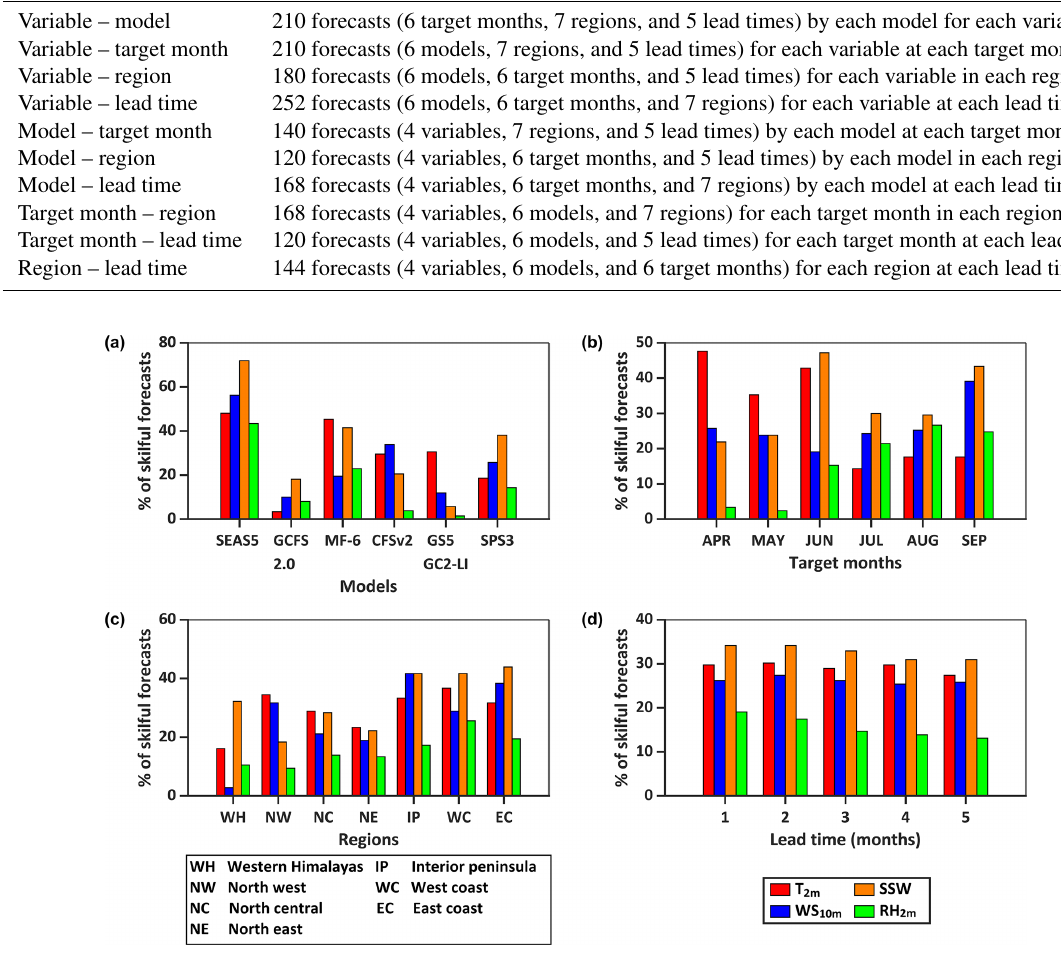
Table 3. Number of forecasts for different combinations of the parameters used in this study. Parameter combination